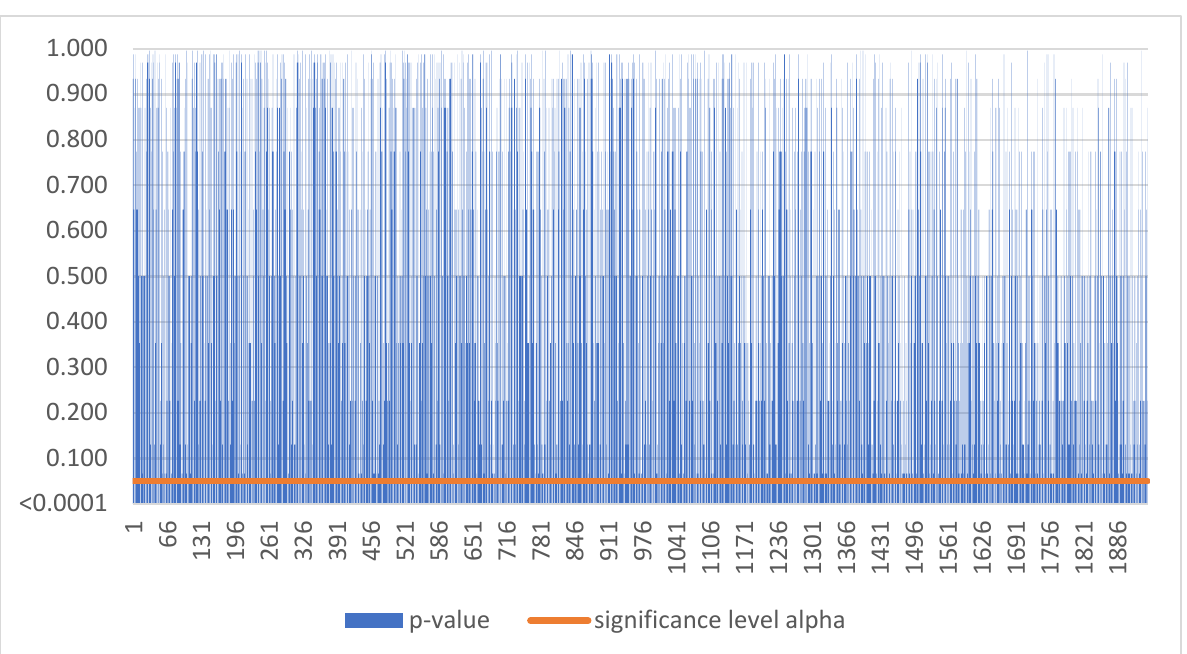
Figure 8. No trend in Hungary.